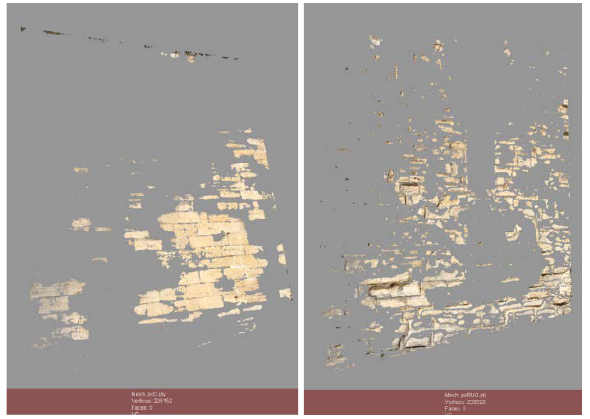
Figure 18. Selection of point cloud, starting from a given value of C2M (cloud to mesh) (left) e R (roughness) (right) and a selectable range.